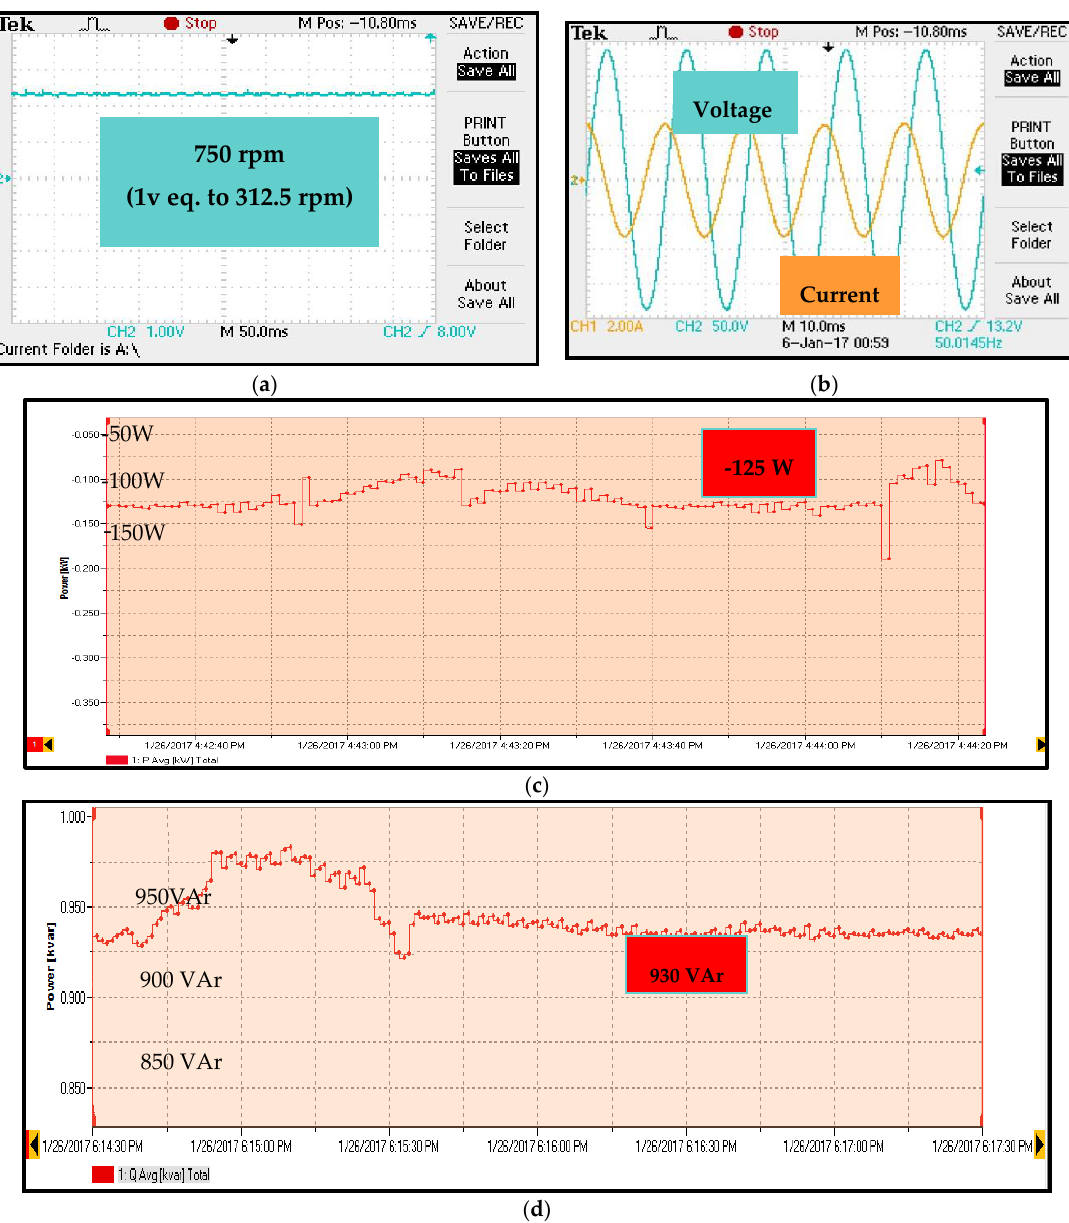
Figure 15. Grid side experimental waveforms for no load test (1): ( a ) speed (V), ( b ) phase A grid voltage and current, ( c ) grid active power (W) [ Y-axis: 25 W / div, X-axis: 10 s / div ], and ( d ) grid reactive power (VAr) [ Y-axis: 25V Ar / div, X-axis: 15 s / div ]. • Test